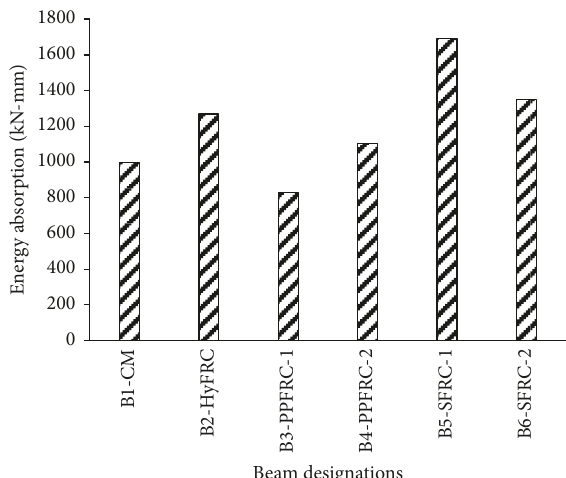
Figure 14: Energy absorption by all girders.